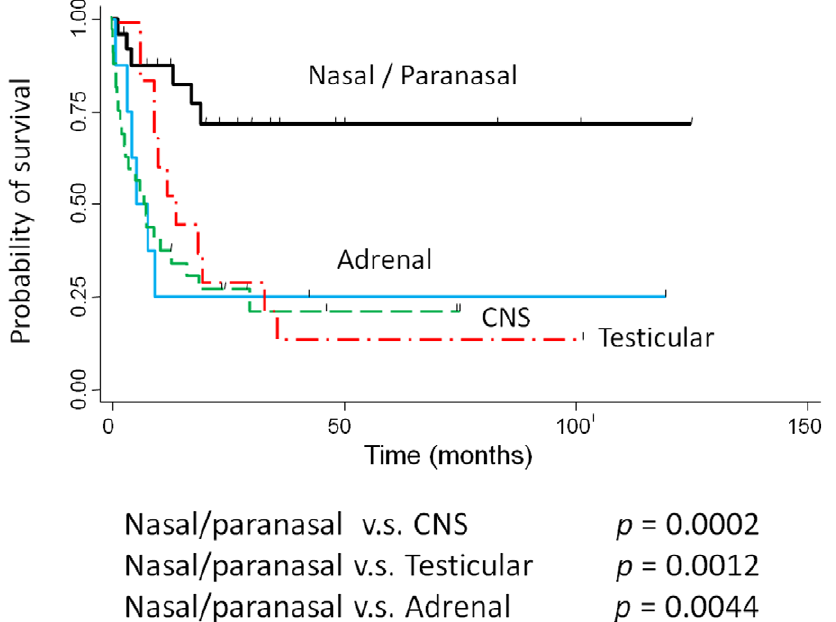
Figure 6. Comparison of overall survival between localized nasal/paranasal DLBCL and localized adrenal, CNS, and testicular DLBCLs.